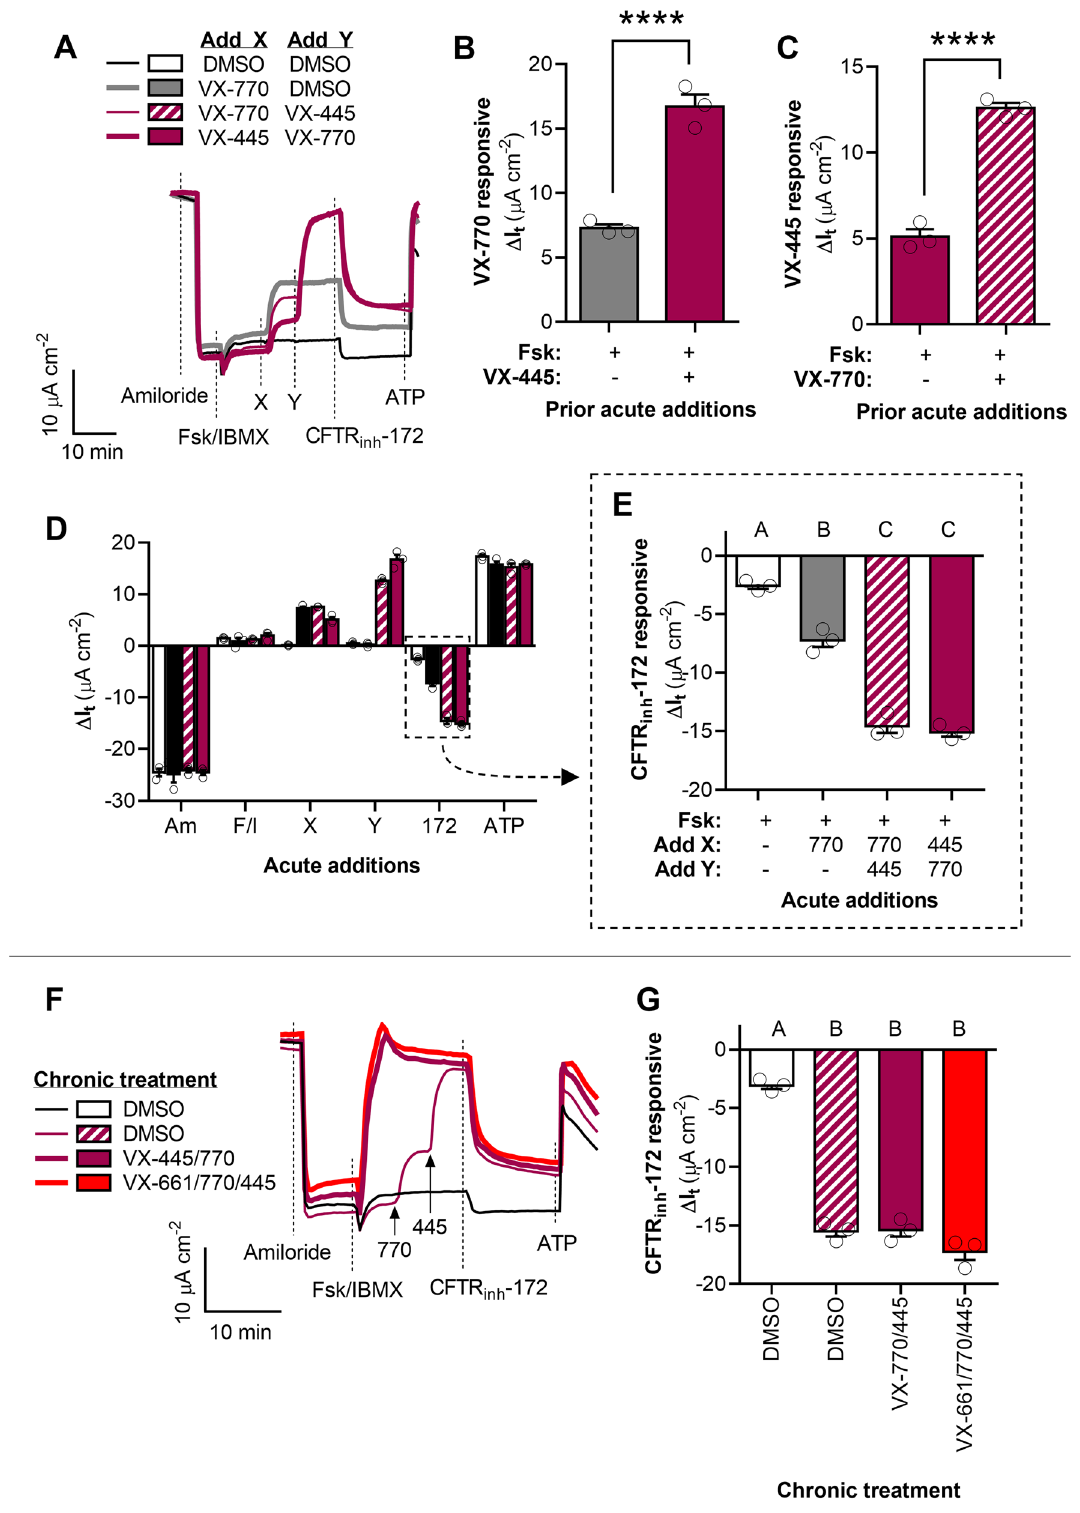
Figure 4. Synergism of ivacaftor (VX-770) and elexacaftor (VX-445) in potentiating G551D-CFTR in HNE cells. ( A ) Representative I t recordings of G551D-HNE cells showing acute actions of VX-770 and VX-445. ( B–C ) Changes in I t after acute addition of VX-770 in the absence and presence of VX-445 ( B ) and in response to the acute addition of VX-445 in the absence and presence of VX-770 ( C ). ( D–E ) Changes in I t after the additions of test compounds for the experiment presented in ( A) . G551D-CFTR mediated I t is greatest after acute potentiation by both VX-770 and VX-445. ( F ) Representative I t recordings of G551D-HNE treated for 24 h with DMSO, the double combination of VX-770 and VX-445, or the triple combination of VX-661, VX-770, and VX-445 (i.e., Trikafta). ( G ) CFTR inh -172 inhibited I t for the experiment presented in ( F) . See SI for additional experimental details and for supporting data. All data are presented as mean ± standard error. Bars with different letters (A, B, C…) are significantly different from each other (ANOVA; P < 0.05). Asterisks indicate specific P values: **** P <